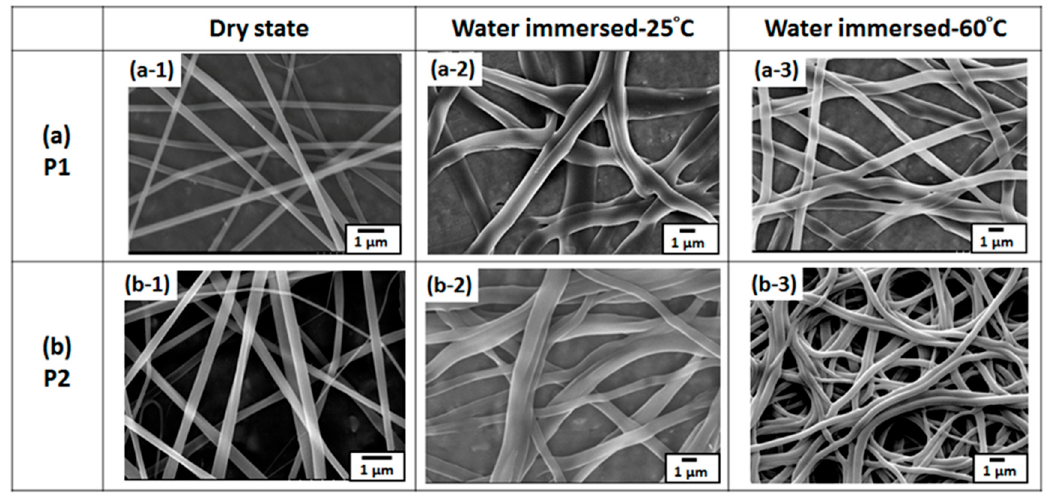
Figure 6. Field-emission scanning electron microscopy (FE-SEM) images of copolymers. ( a ) P1 and ( b ) P2 cross-linked nanofibers at 120 °C in a dry state and treated with water at 30 and 60 °C.